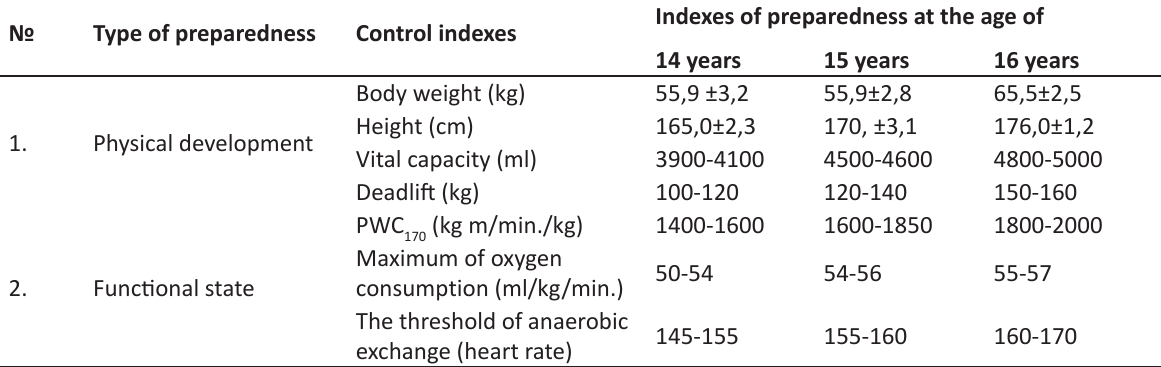
Table 1. Indicators of physical development and functional state of schoolchildren-athletes of 14-16 years